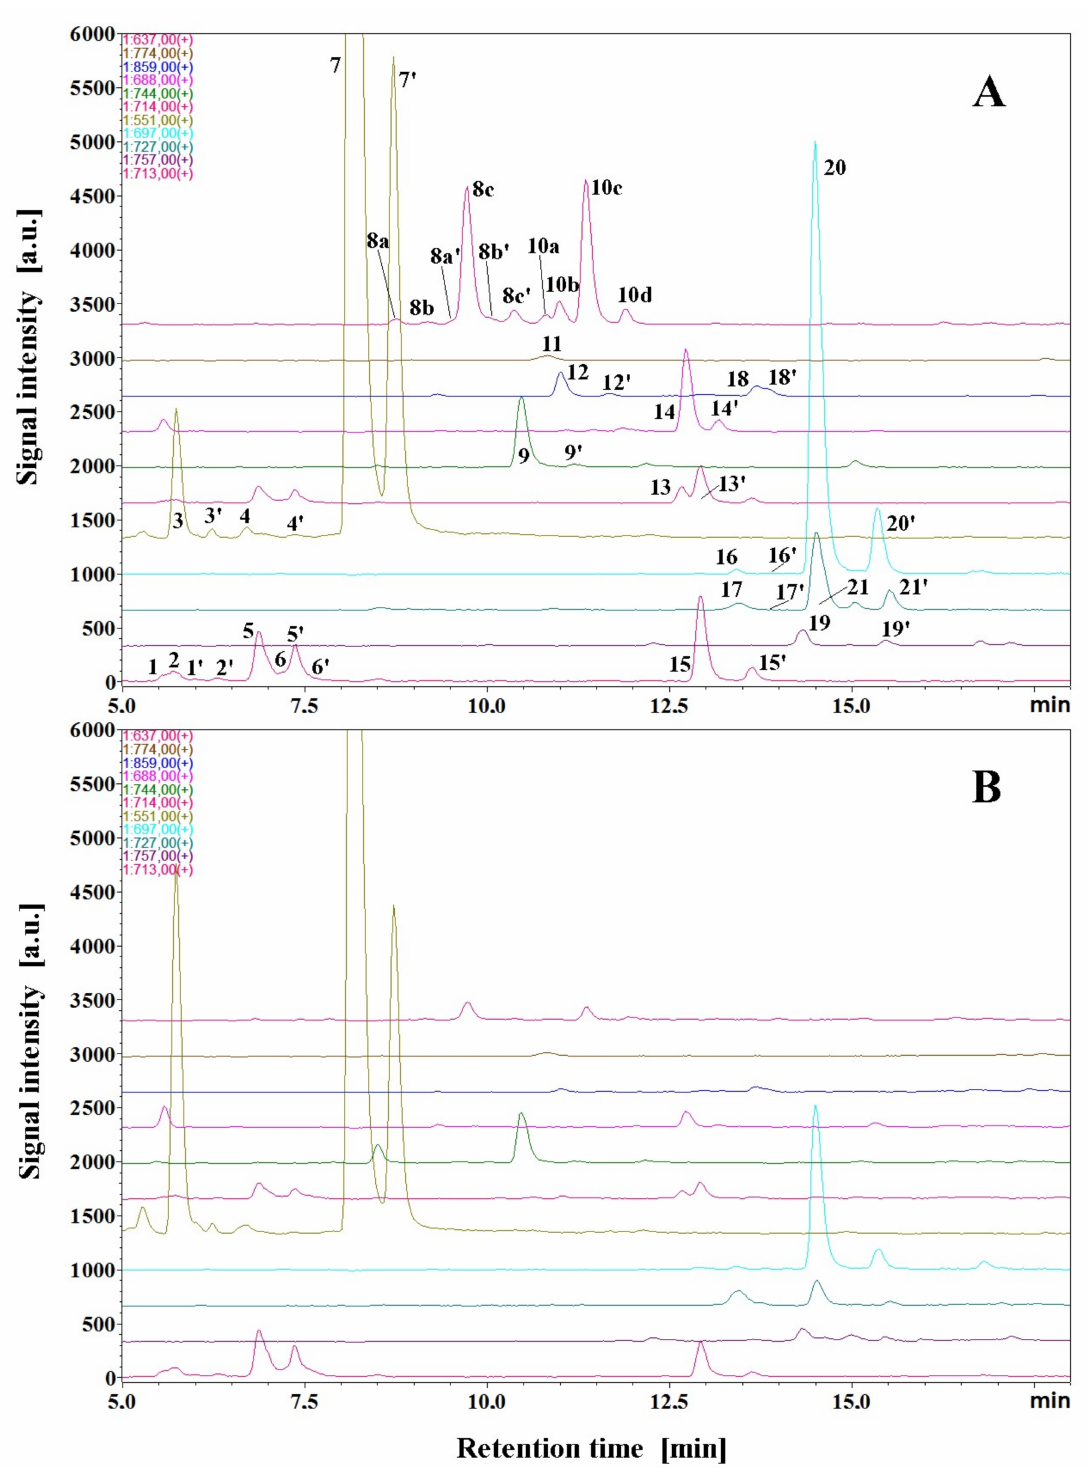
Figure 3. Betacyanin fingerprints in B. alba ( A ) and B. alba var. ‘Rubra’ ( B ) fruits in the form of high- performance liquid chromatograms for selected ions obtained in the LRMS LC-DAD-MS